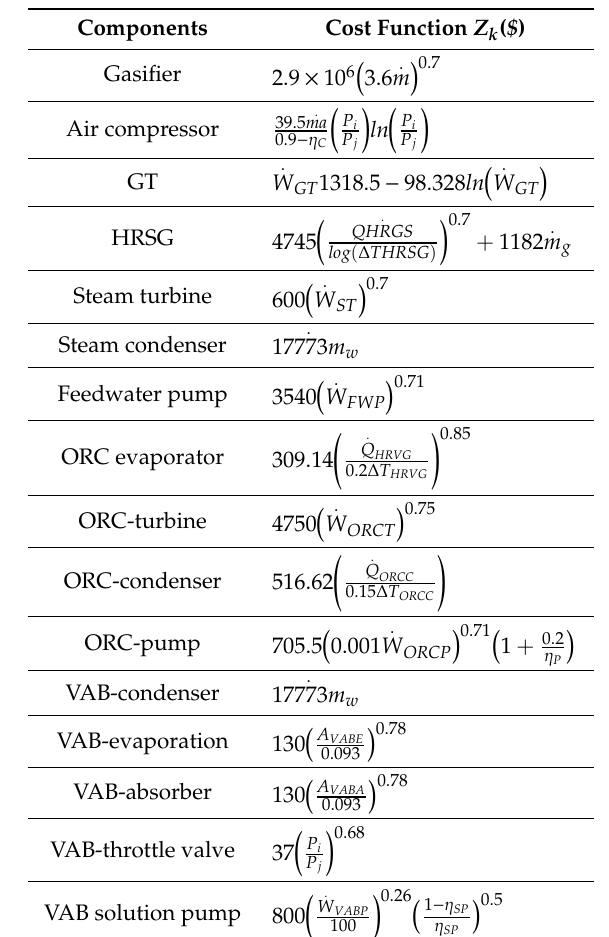
Table 1. Equipment cost